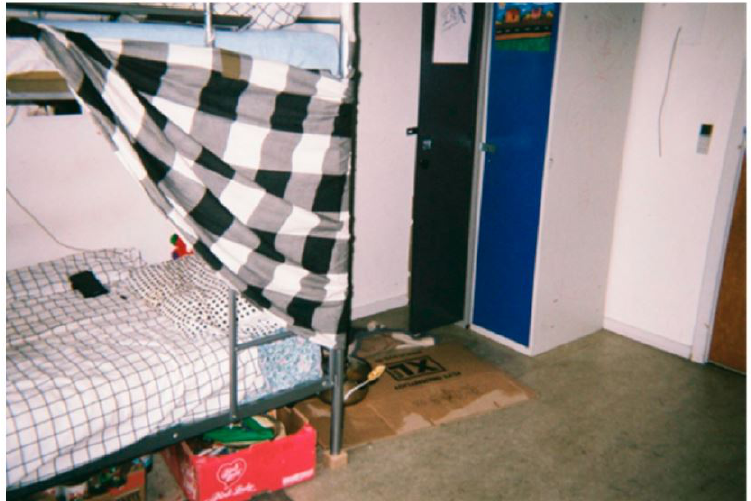
Figure 1. Shared room between one of the adolescents and two other boys, showing how the boys kept all their belongings under the bed, including pots and groceries (Source: